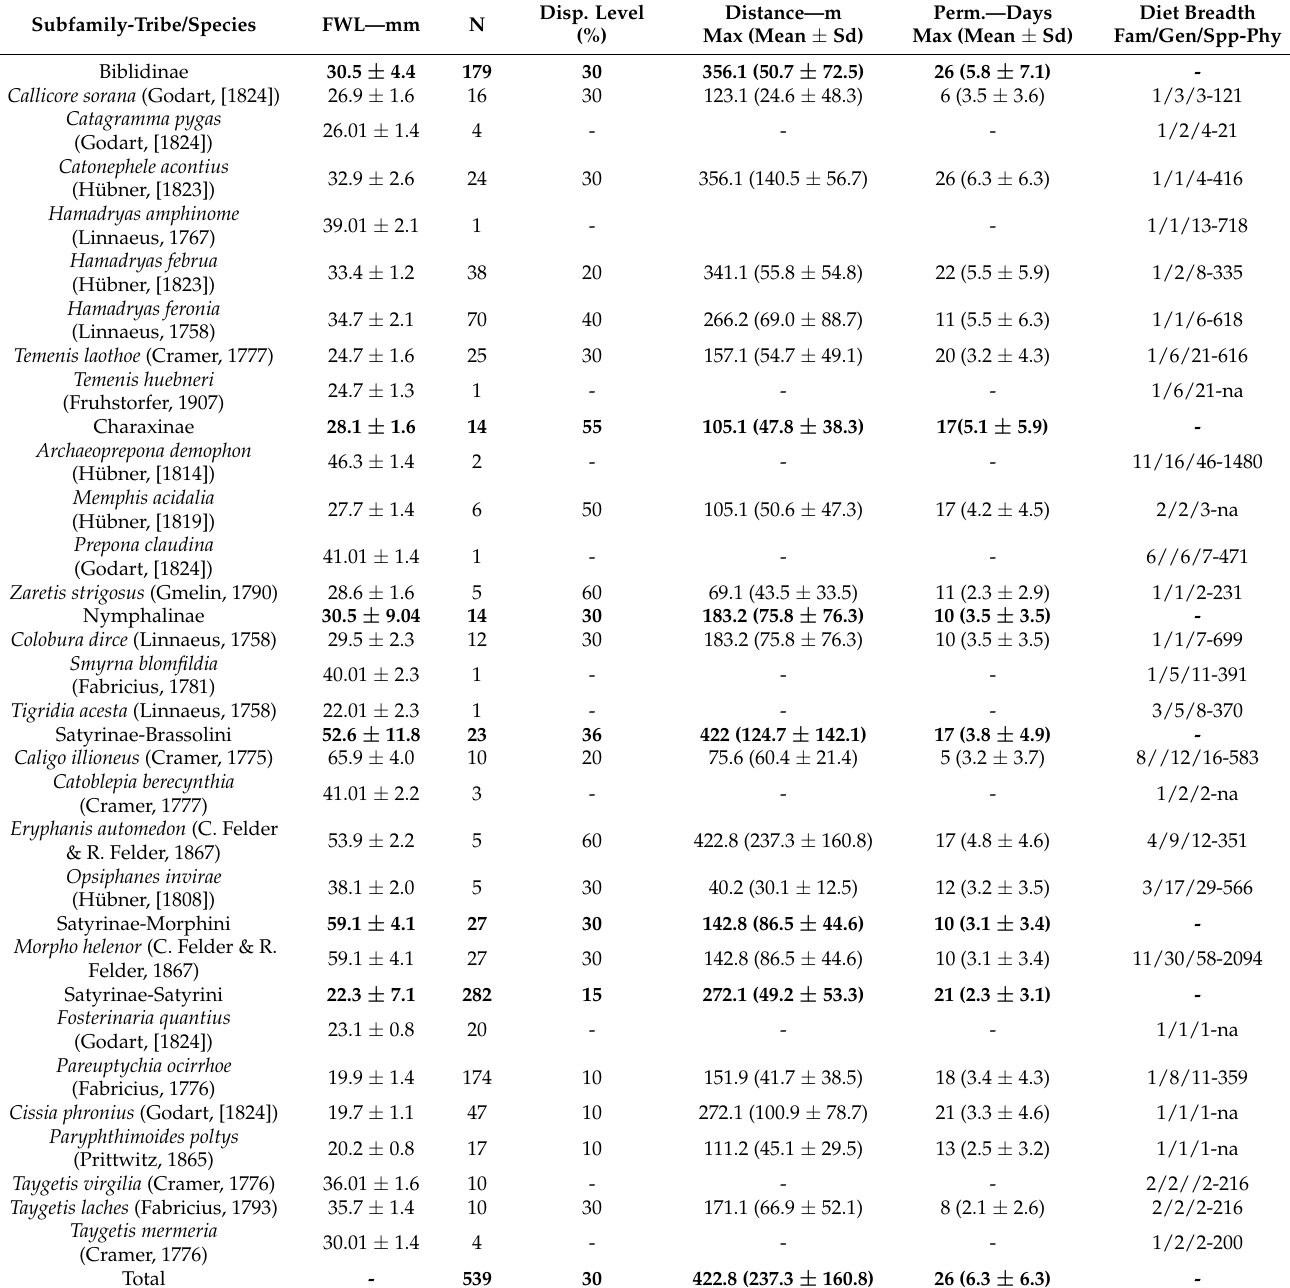
Table A1. Forewing length (FLW); abundance (N); dispersal level (%); dispersal distance (m); permanence (days); and diet breadth based on the number of family, genera, species, and phylogenetic relatedness of host plants (Fam/Gen/Spp-Phy, respectively) of fruit-feeding butterfly species captured in 35 consecutive days at Fazenda Á gua Limpa, Bras í lia, Brazil.